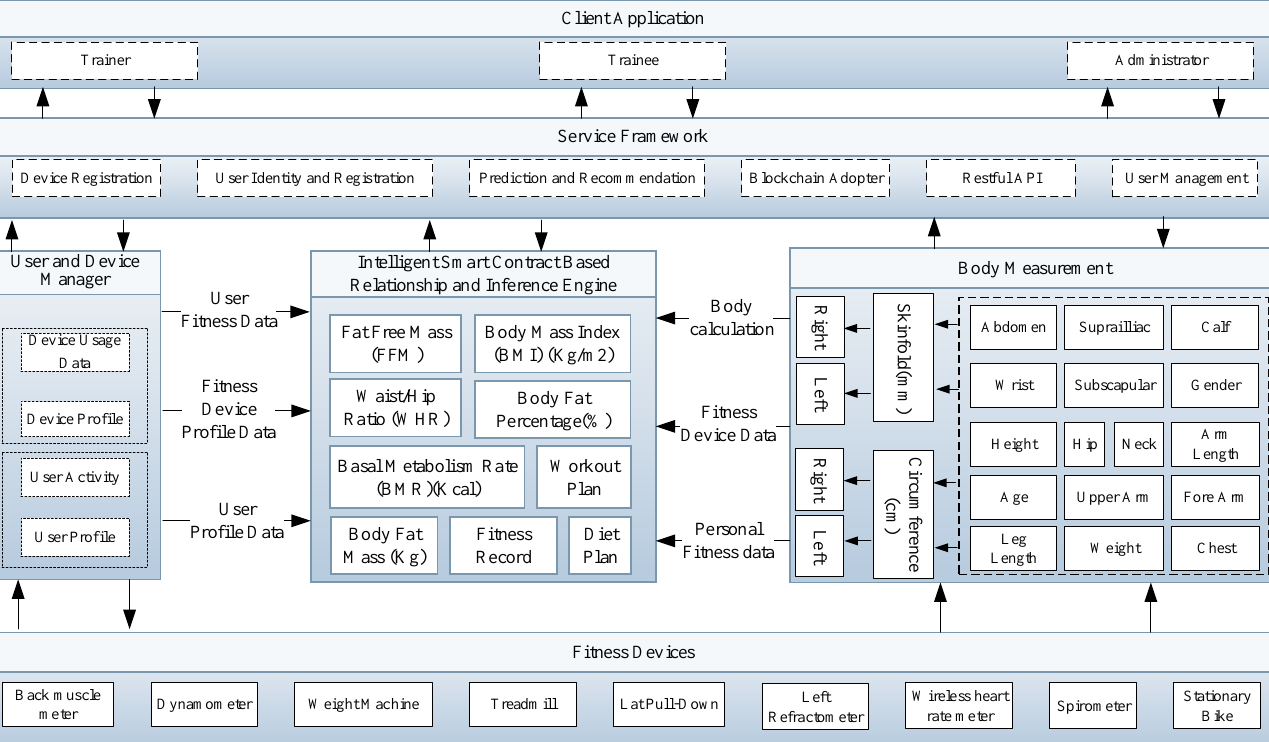
Figure 7. Proposed intelligent fitness service based on enhanced smart contract enabled relationship and inference engine in IoT